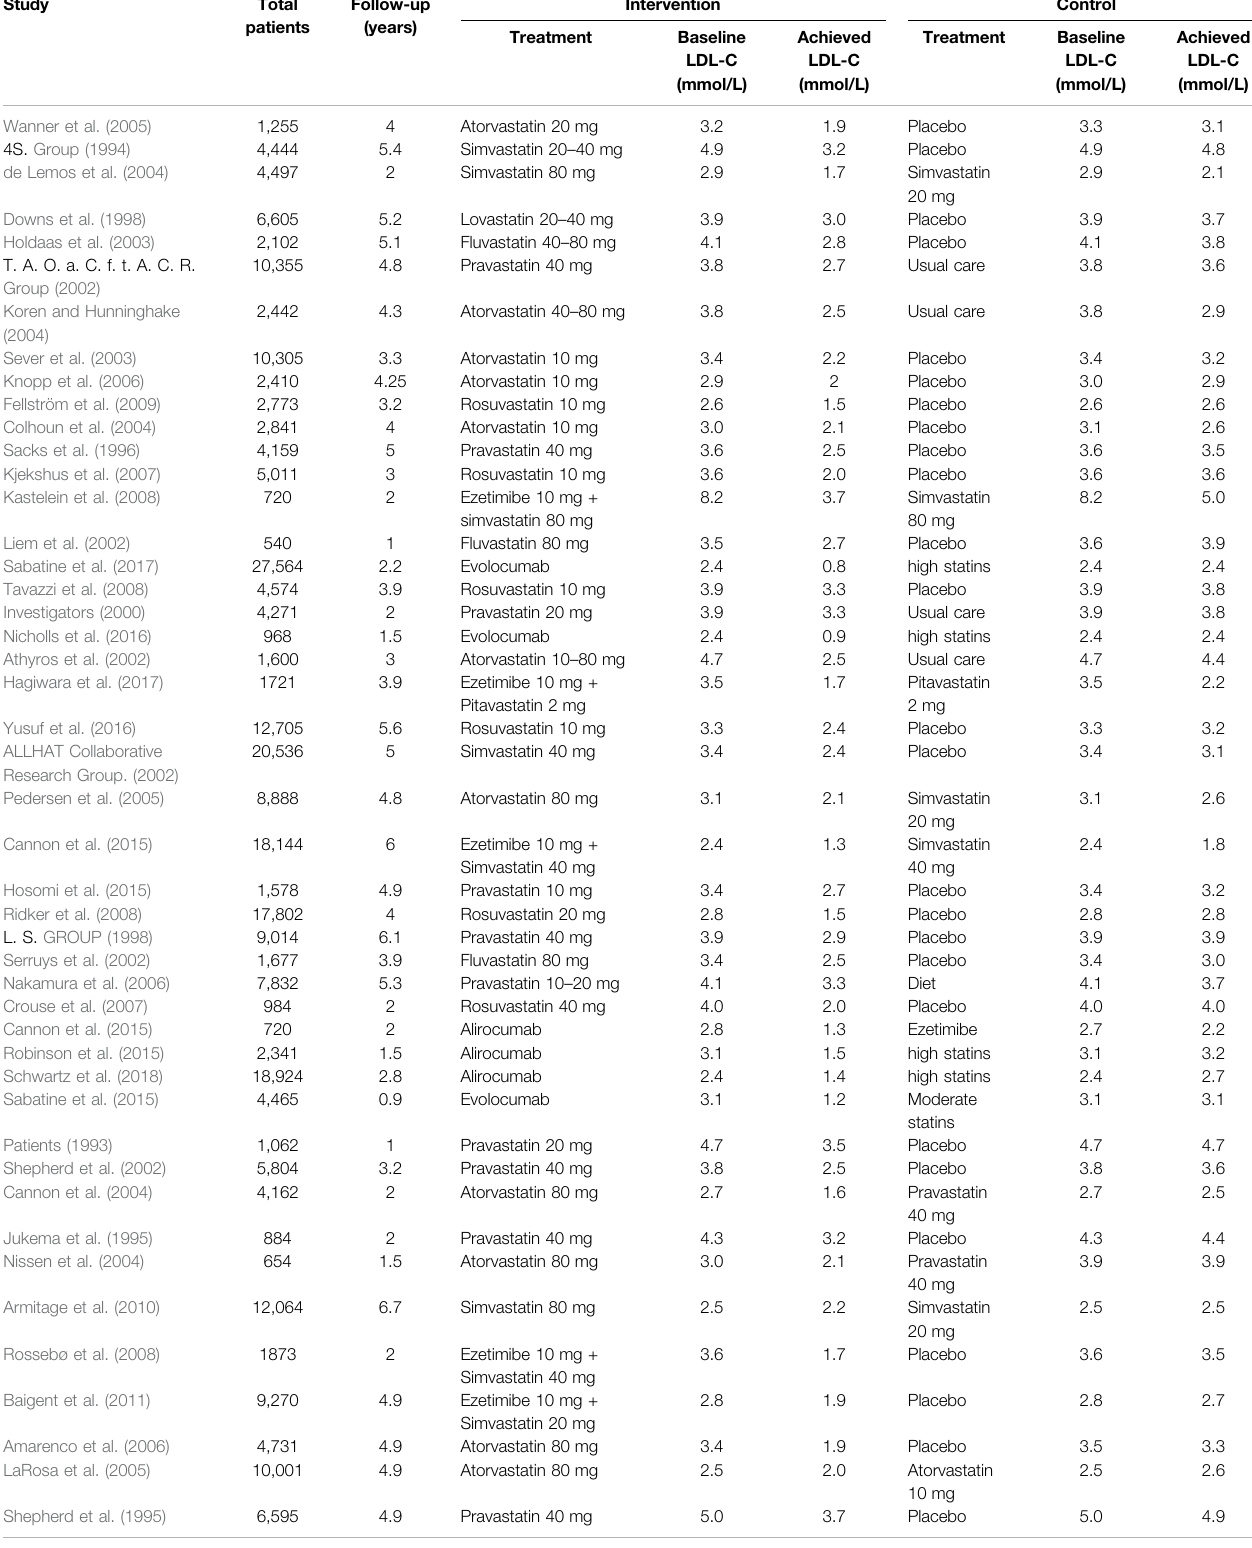
TABLE 1 | Characteristics of trials fi nal included in the network meta-analysis.